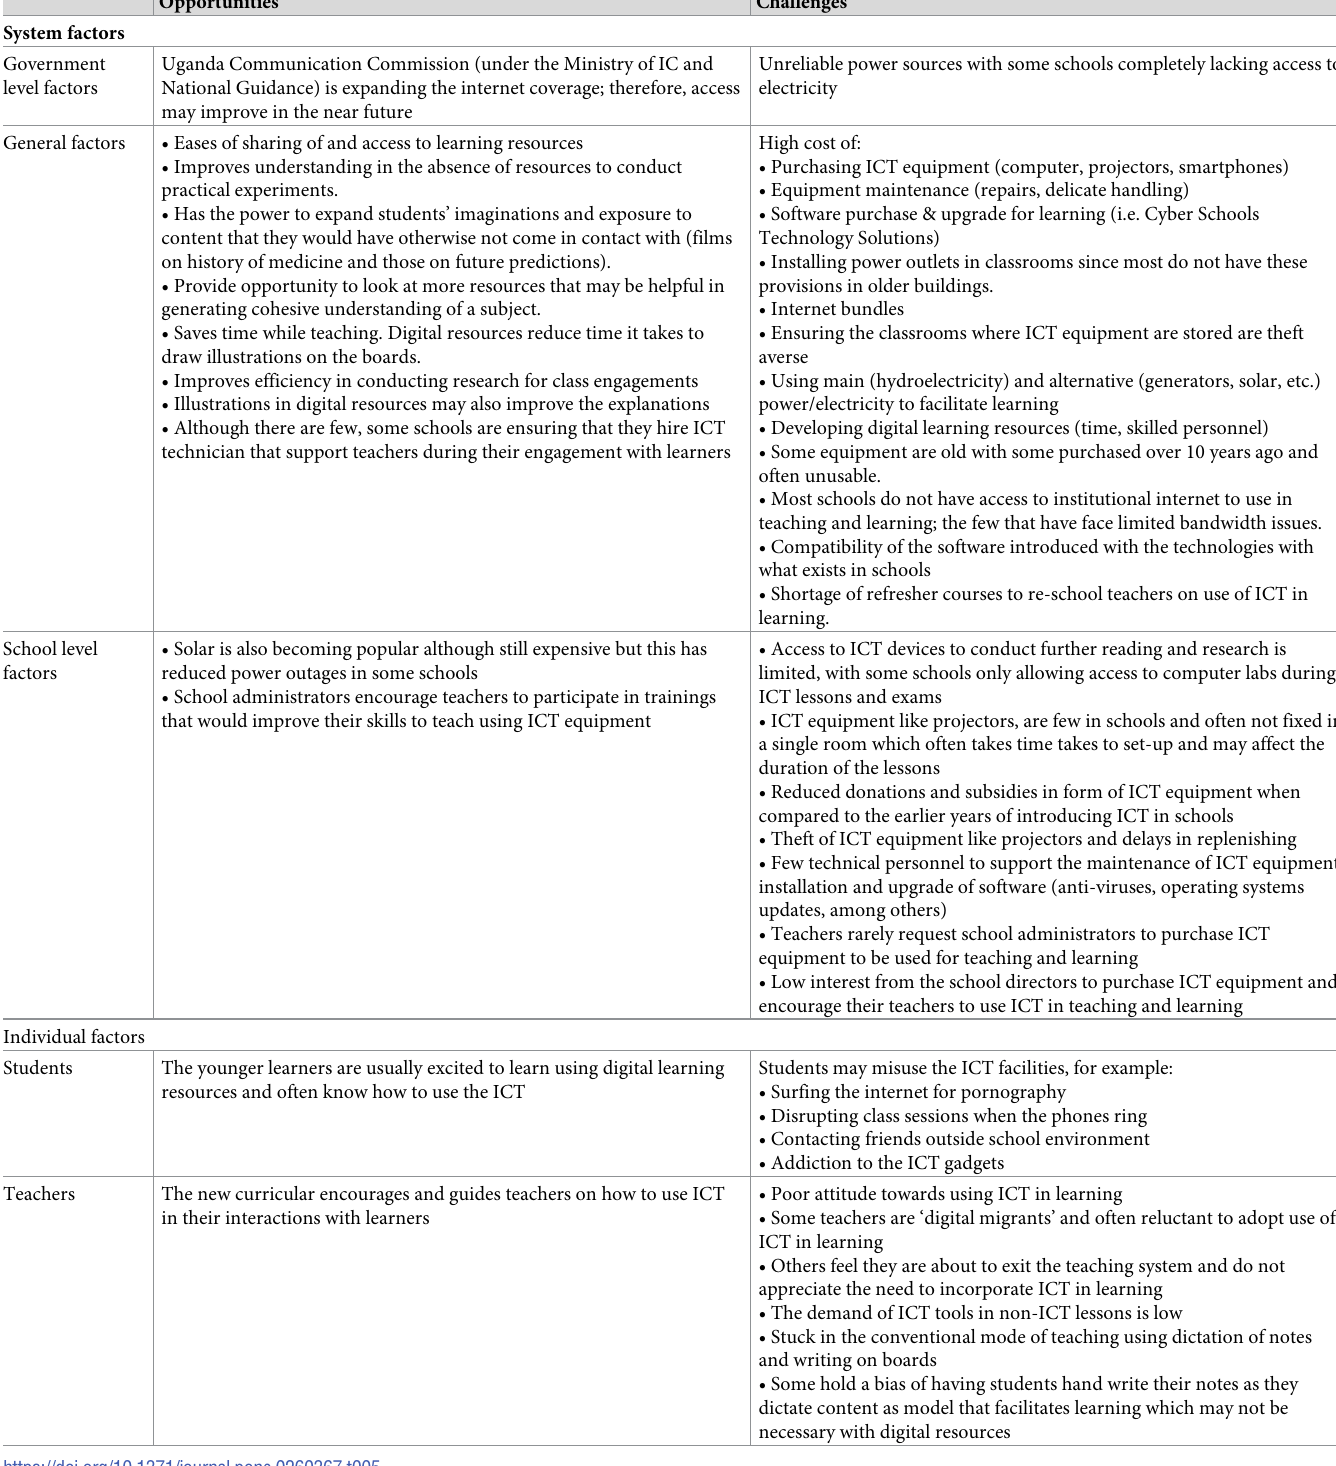
Table 5. Opportunities and challenges for using digital learning